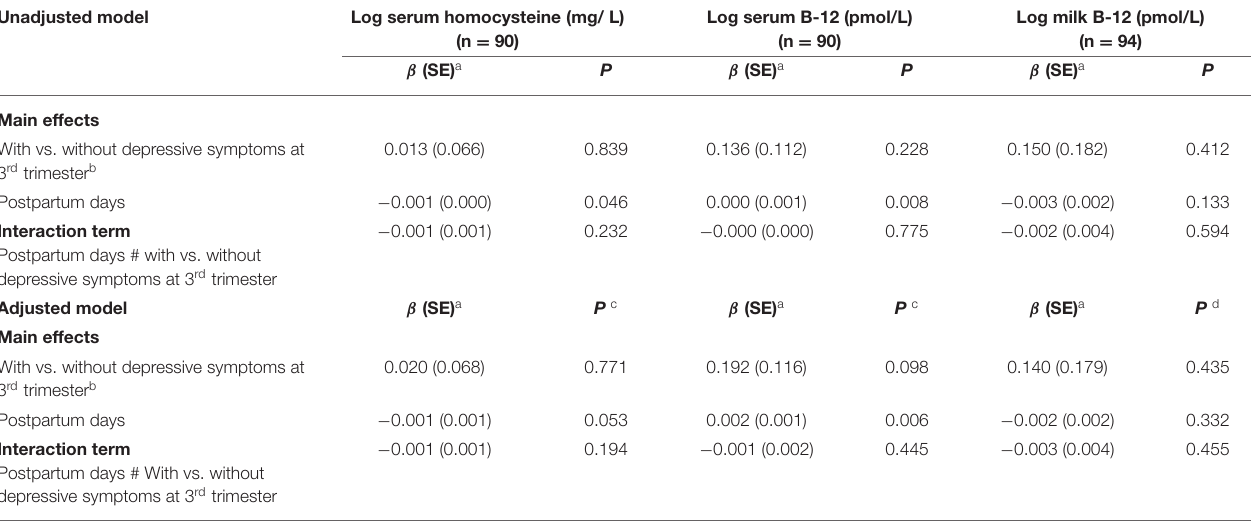
TABLE 2 | Models of longitudinal prediction of serum homocysteine and vitamin B-12 and milk B-12 trajectories based on the presence of depressive symptoms at the 3 rd trimester of pregnancy, Rio de Janeiro, Brazil. Unadjusted